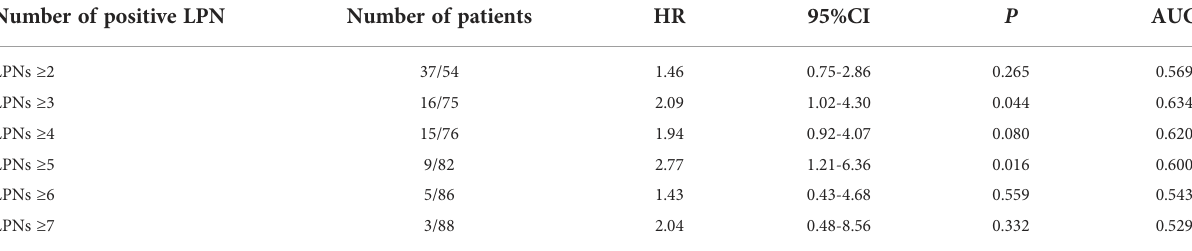
TABLE 6 The distribution of the number of LPNs in 91 patients with LPN metastases.